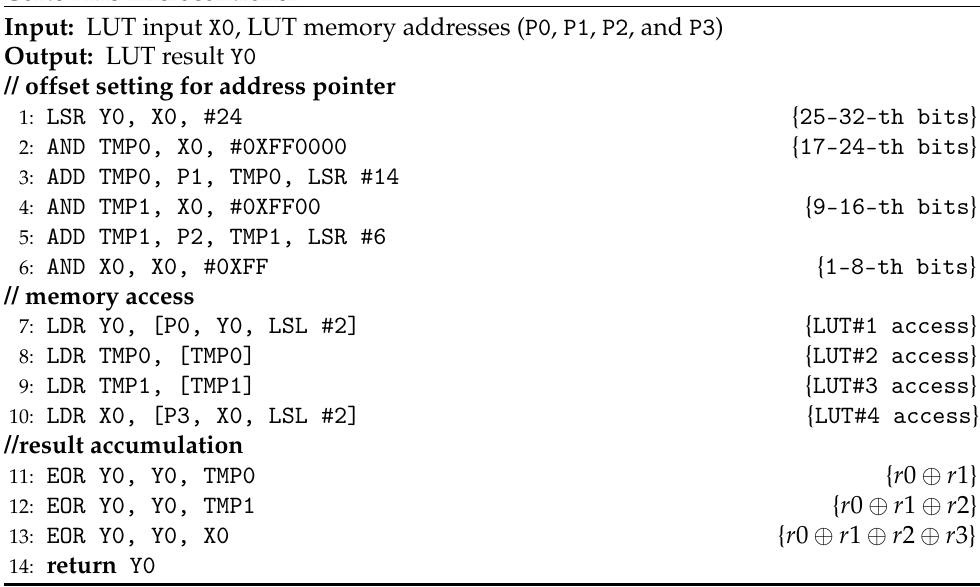
Algorithm 4 Pipelined LUT access for M · S layer of ARIA block cipher on the ARM Cortex-M3 microcontroller.